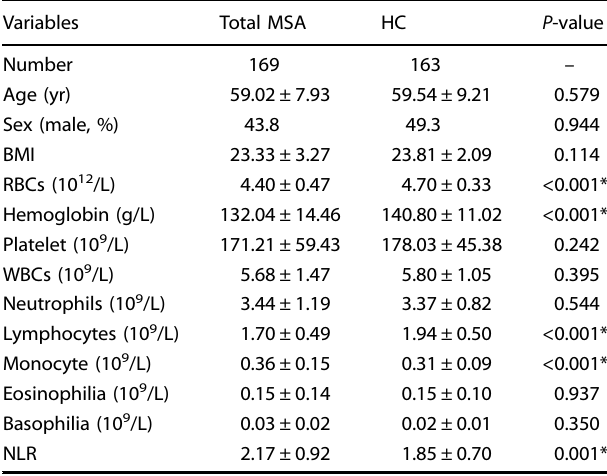
Table 1. Demographic and the hematological data of MSA and HC.